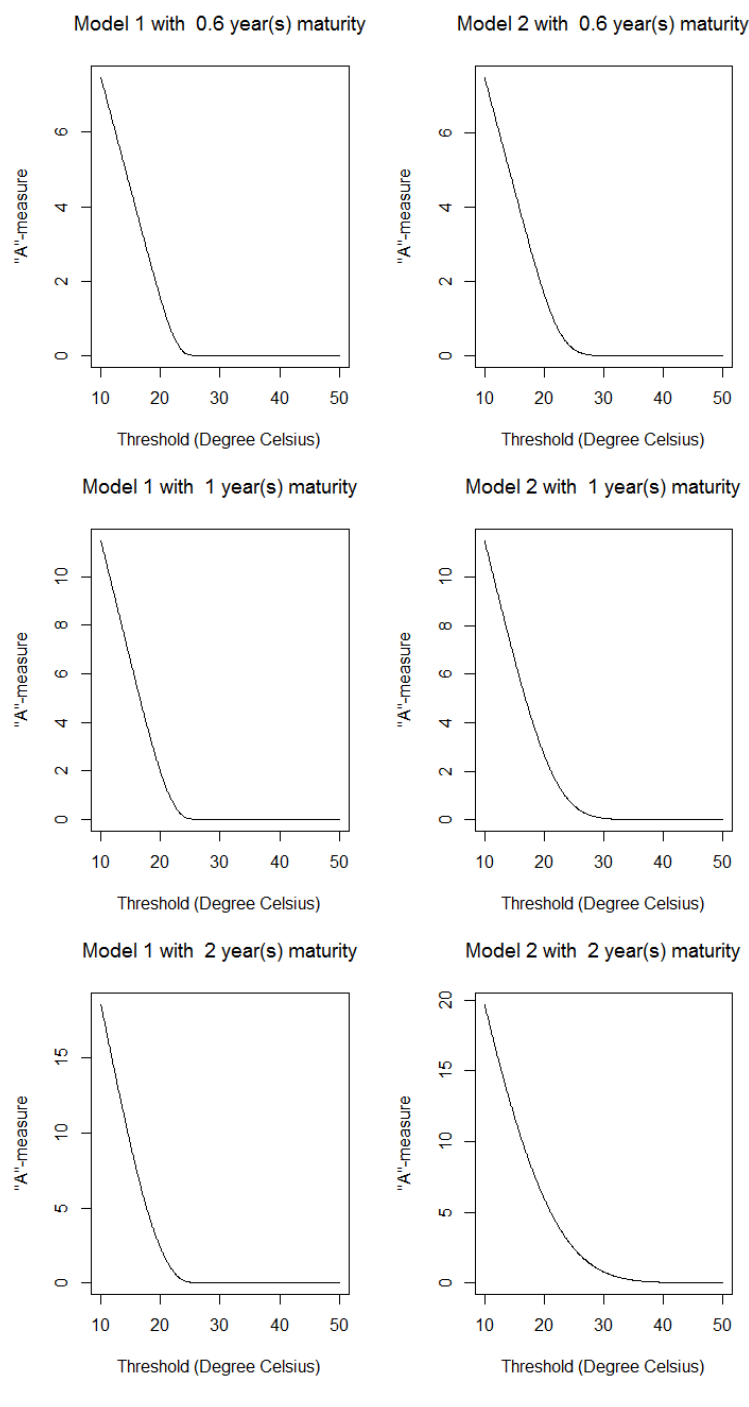
Figure 1. A-measure for both Model 1 Equation (10) and Model 2 Equation (11) with initial temperature equal to 24 ◦ C and maturity time equal to six months (at the top-left corner), one year (at the top-right corner), two years (at the bottom-left corner) and five years (at the bottom-right corner). A-measure is plotted as a function of threshold (from 10 ◦ C to 50 ◦